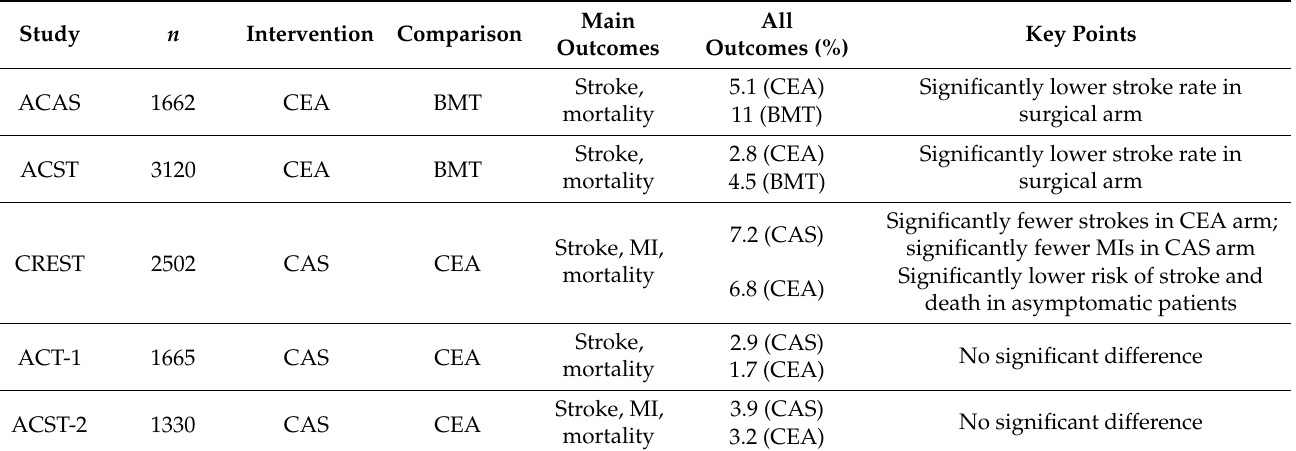
Table 1. Comparison of outcomes among carotid endarterectomy, carotid artery stenting, and best medical